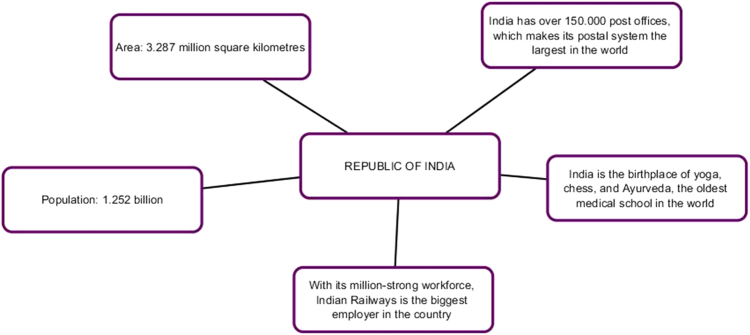
Infographics “Republic of India” [1].